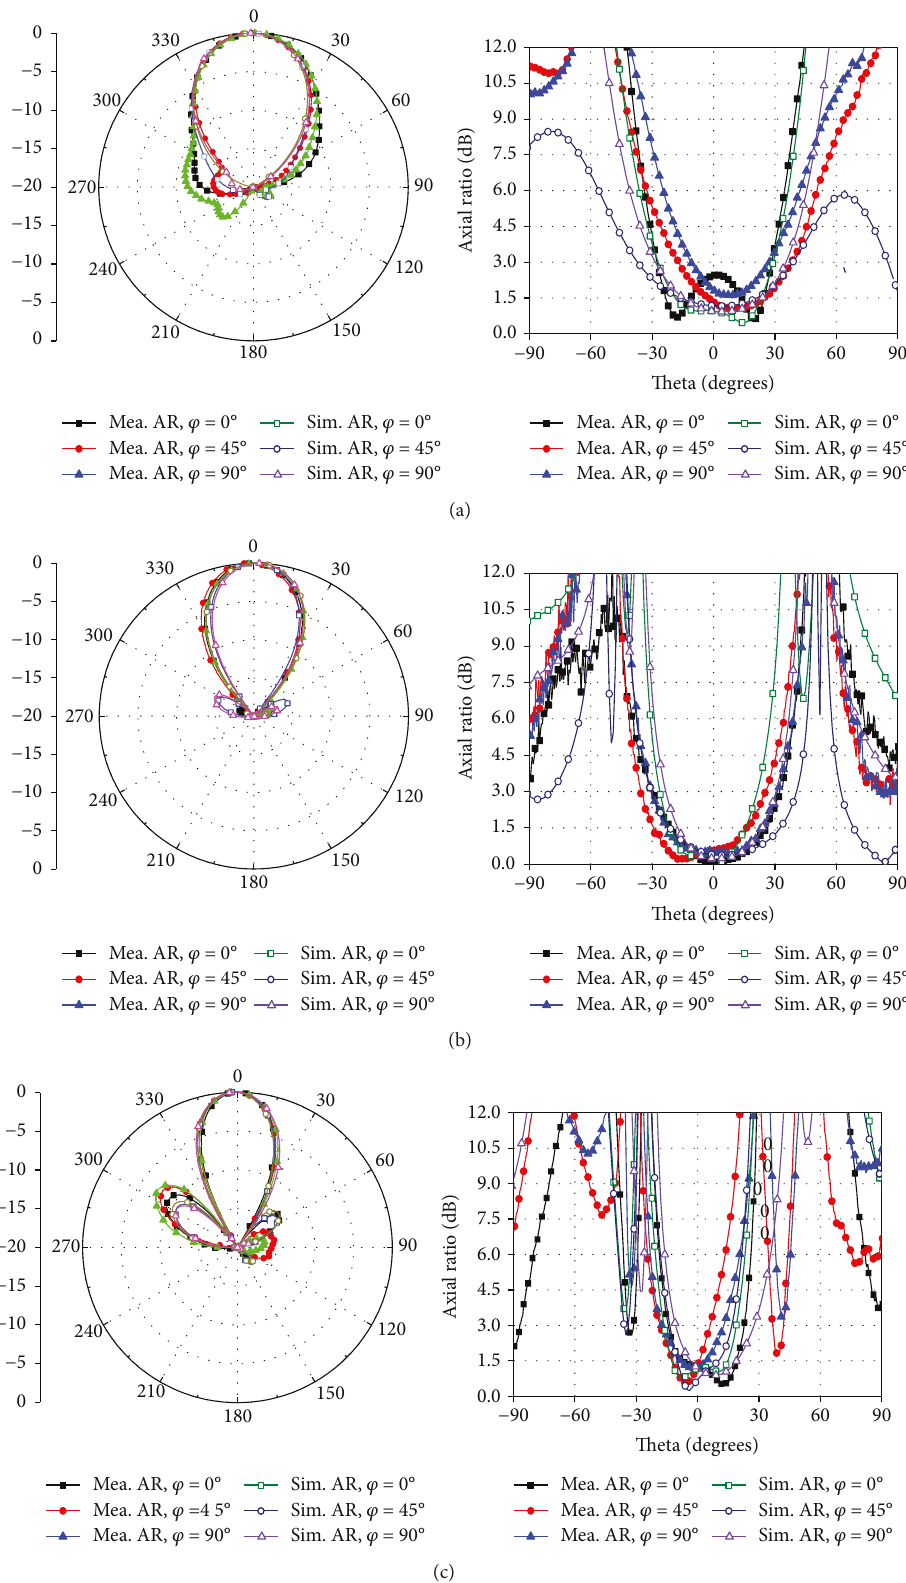
Figure 11: Simulated and measured radiation patterns and axial ratios of the array. (a) 1.6GHz. (b) 2.1GHz. (c)